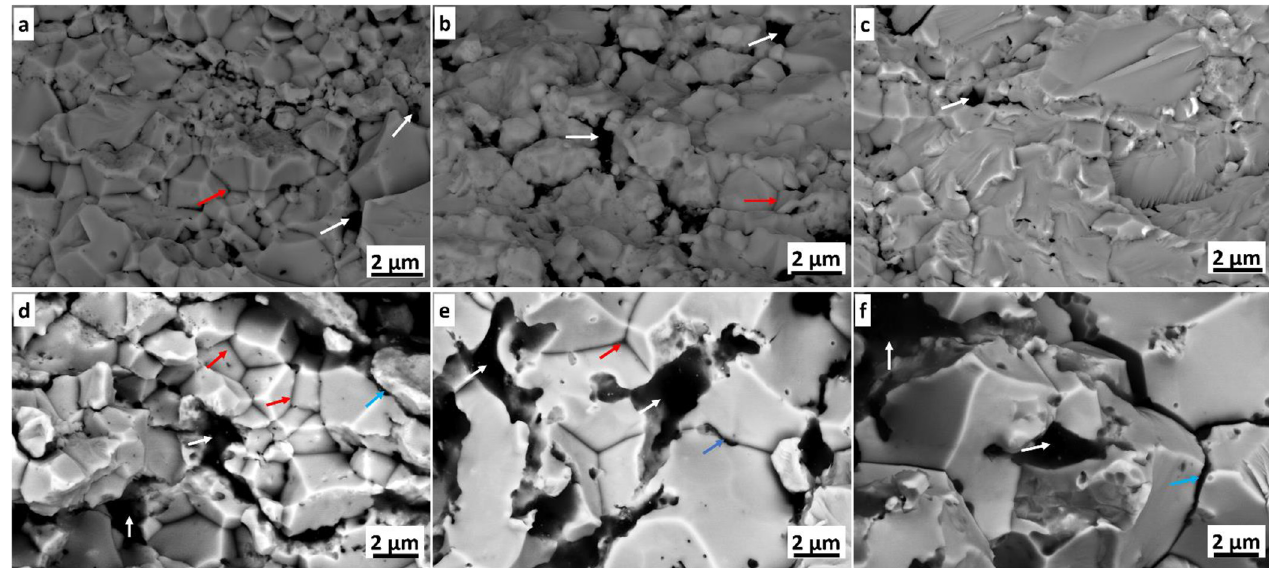
Fig. 2. SEM fractured morphology of the consolidated samples from 50 to 150 ° C/min (a – c) NiAl, and (d – f)